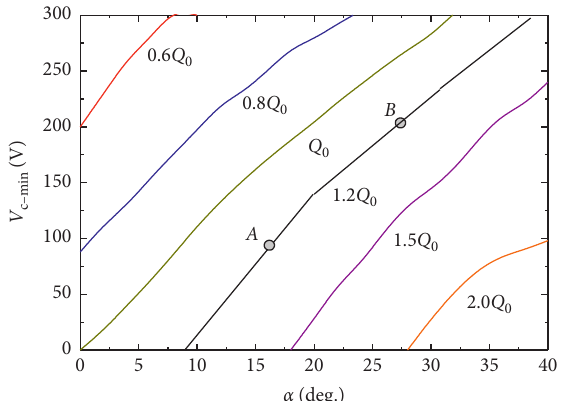
Figure 10: Equivalent reactive surface.